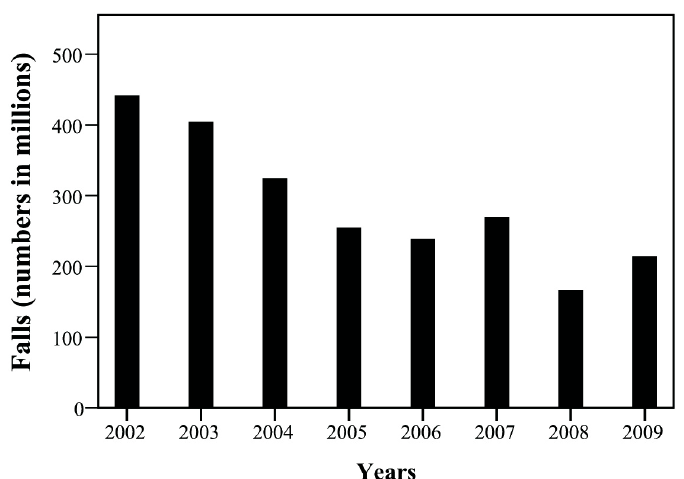
Figure 1. The temporal change of motor vehicle accidents between 2002 and 2009.